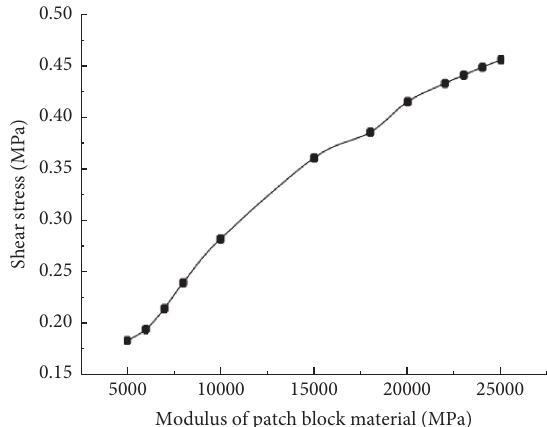
Figure 13: The effect of patch material modulus on tensile stress of joint filling materials.